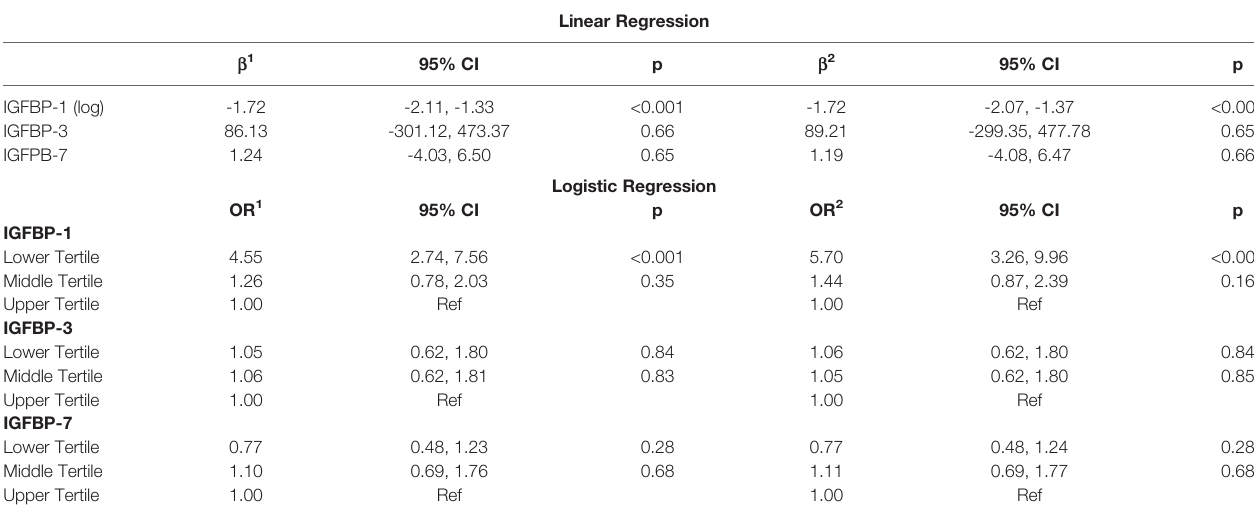
TABLE 3 | Association of IGFBPs with waist-to-height ratio in adolescents.